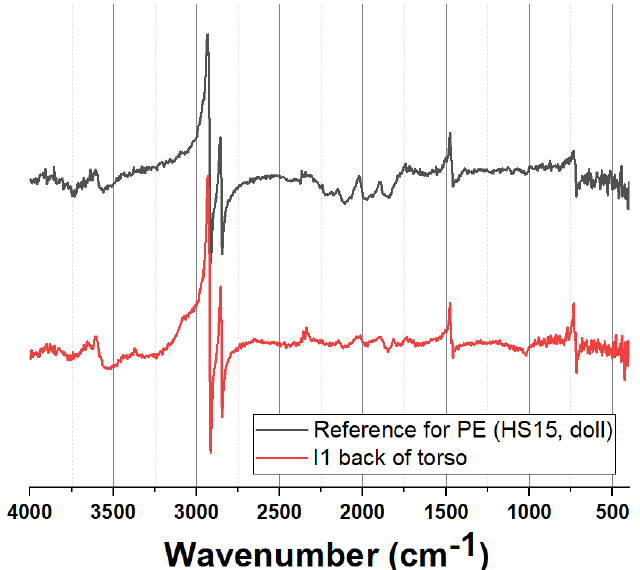
Figure 5. Typical ER-FTIR spectrum for polyethylene dolls, illustrating the acquired spectrum for doll E1 (back of torso) and a reference spectrum for PE.